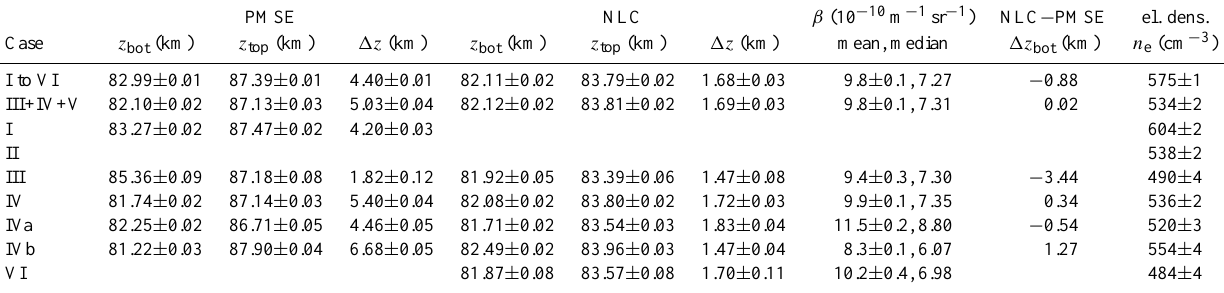
Table 3. Mean layer boundaries, separation of NLC and PMSE bottom altitudes and NLC brightness for each of the defined cases. Addi- tionally, electron density from the IRI model is given. Data of the years 1999–2008 is averaged. PMSE NLC el.